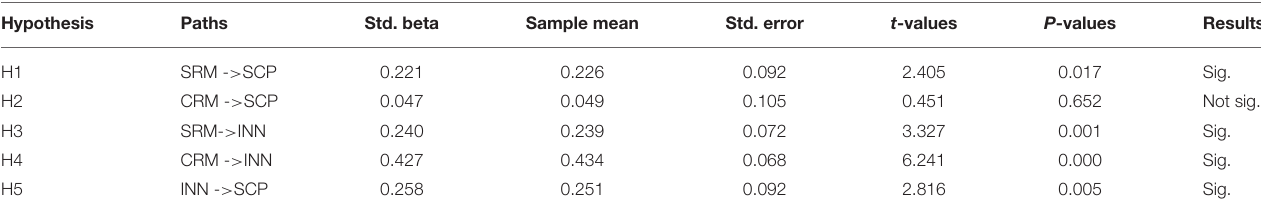
Hypothesis Paths Std. beta Sample mean Std. error t -values P -values